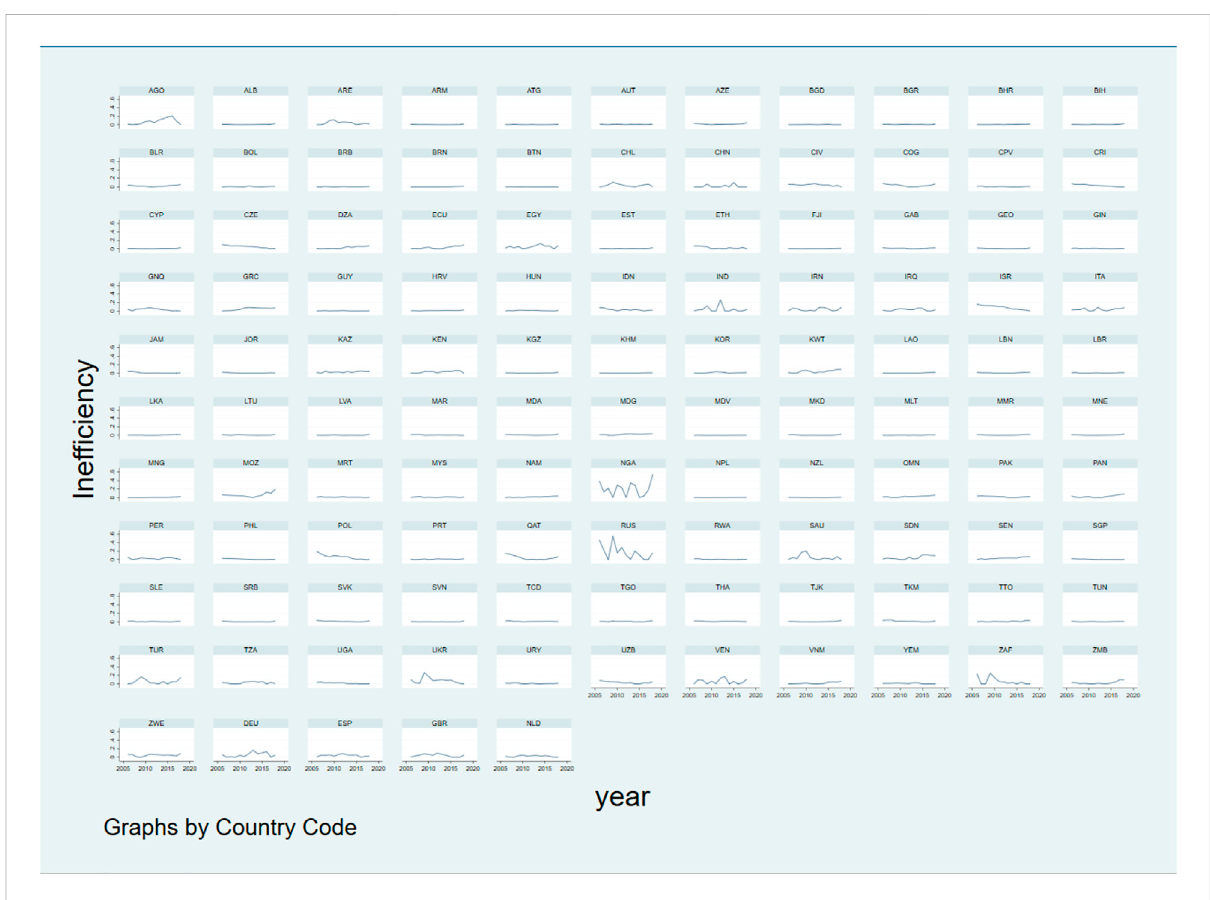
FIGURE 2 Time trend of inef fi ciency for each BRI